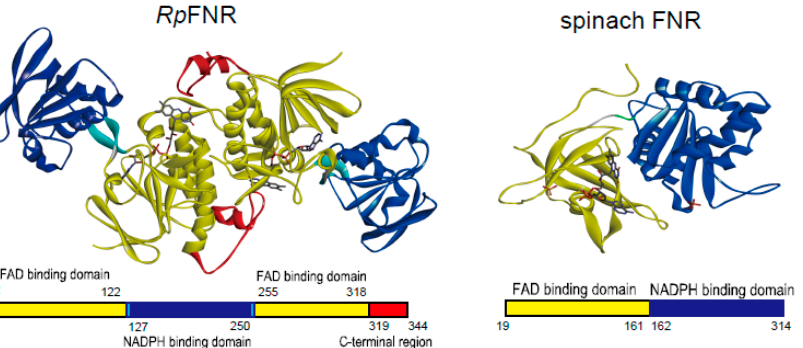
Figure 1. Ribbon diagrams of Rp FNR (homo-dimer, PDB ID: 5YGQ) and spinach FNR (PDB ID: 1FNB). The domain organizations are indicated at the bottom. FAD-binding and NADP + /H-binding domains are colored yellow and blue, respectively, and the C-terminal region of Rp FNR is in red. Bound FAD co-factor is represented as a stick model. The figure was prepared using BIOVIA Discovery Studio Visualizer (Ver. 21.1, Dassault Systèms).